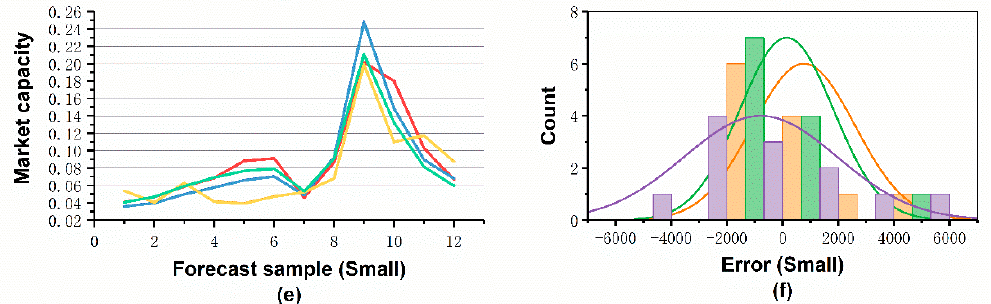
Figure 11. A comparison of short-term prediction result of modified model versus SARIMA model and the SVR model on the forecast set. ( a ) indicates the curve of large-scale excavator market capacity. ( b ) indicates Gaussian distribution of prediction errors on the large-sized type. ( c ) indicates the curve of medium-scale excavator market capacity; ( d ) indicates Gaussian distribution of prediction errors of the medium-sized type. ( e ) indicates the curve of small-scale excavator market capacity; ( f ) indicates Gaussian distribution of prediction errors of small-sized type.